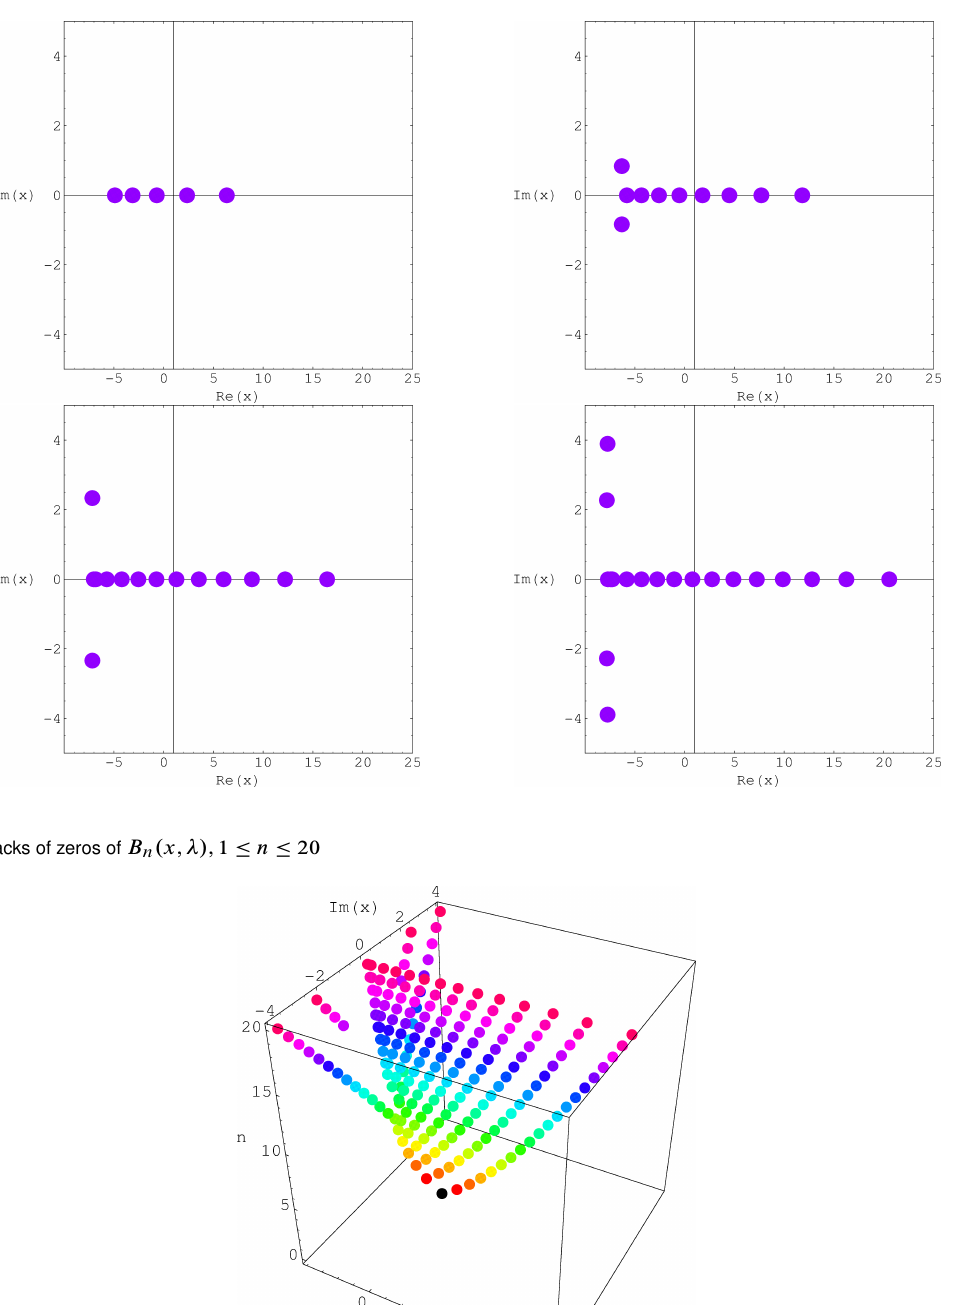
Fig. 3. Zeros of B n .x;(cid:21)/